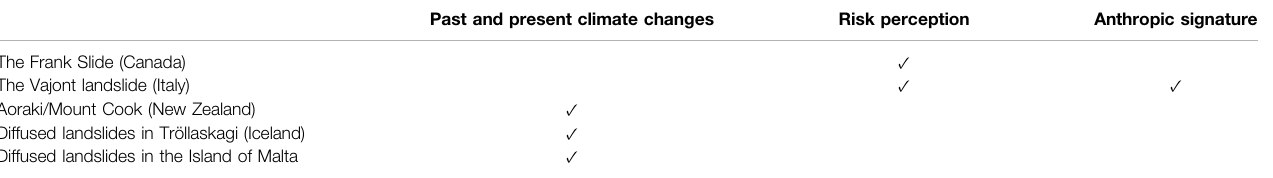
TABLE 3 | The chosen landslide examples showcasing the new values for the identi fi cation of a landslide